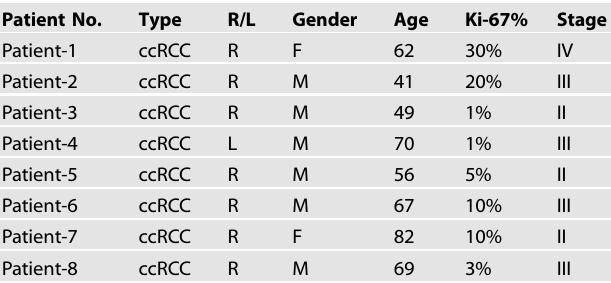
Table 1. Patient